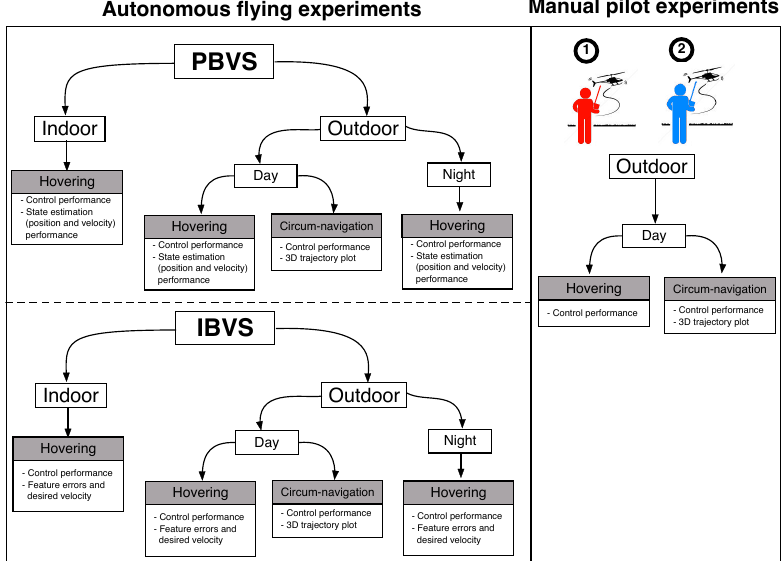
Figure 17. Overview of experiments. There are two categories: autonomous flying with shared autonomy ( left ) and manual piloting with only attitude stabilization ( right ); Autonomous flying consists of PBVS ( top ) and IBVS ( bottom ). Two pilots were involved in the manual piloting experiments. Each box with grey denotes a sub-experiment and describes key characteristics of that